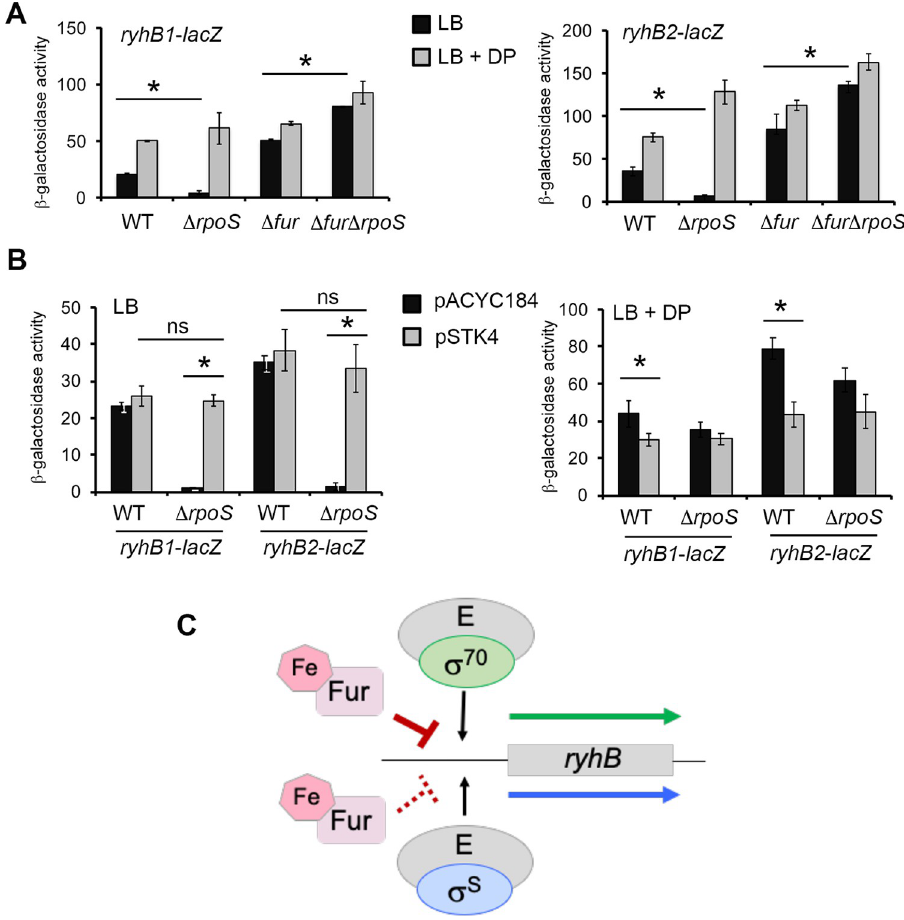
Fig 2. Expression of ryhB1-lacZ and ryhB2-lacZ transcriptional fusions in Salmonella . (A) Expression of the ryhB1-lacZ and ryhB2-lacZ transcriptional fusions was followed in Salmonella wild type, Δ rpoS , Δ fur and Δ rpoS Δ fur strains (S1 Table) grown 18 h in LB supplemented or not with 2,2’-dipyridyl (DP) 100 μ M. (B) Empty vector pACYC184 and plasmid pSTK4 carrying the rpoS gene (S1 Table) were used in complementation experiments. (A, B) Bar graphs represent the mean β -galactosidase activity, and error bars represent standard error of the mean of at least three independent experiments ( � p < 0.05, ns not significant). (C) Schematic illustration of regulation of ryhB genes by σ S and Fur. In stationary phase of growth, E σ S and E σ 70 RNAP compete for binding to the ryhB1 and ryhB2 promoters. When iron is available, Fur-Fe 2+ dimers bind to the ryhB promoter regions and repress σ 70 -dependent transcription. E σ S is less sensitive to Fur-mediated repression than E σ 70 and allows transcription of ryhB1 and ryhB2 . The exact mechanisms by which E σ S escapes Fur-mediated repression is unknown. Since the Fur binding sites overlap the promoter regions (Fig 3A), it is likely that Fur inhibits ryhB1 and ryhB2 transcription by occluding the promoters to prevent E σ 70 binding. E σ S might be more efficient than E σ 70 to compete with Fur for binding to the Fur box/ -10 region. However, the possibility that counter-silencing involves a structural change at the DNA level that allows E σ S binding despite the presence of Fur cannot be excluded.